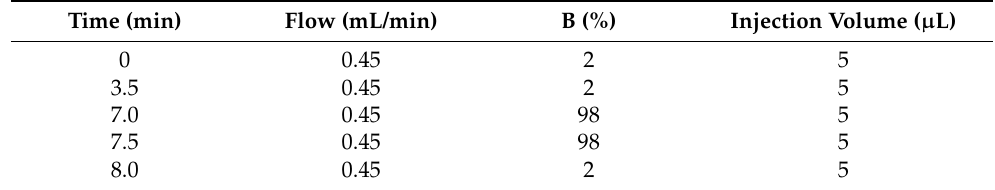
Table 2. Optimum chromatographic conditions of the three main anthranilamide species. Time (min) Flow (mL/min) B (%) Injection Volume ( µ L)